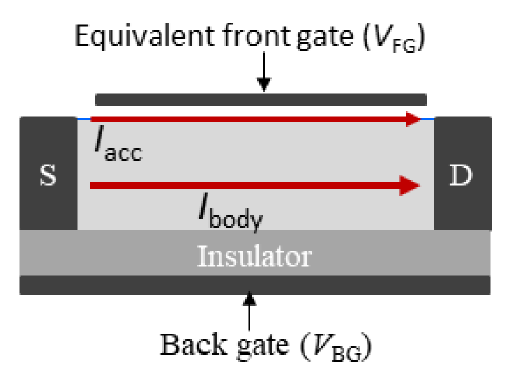
Figure 6. The drain current in the accumulation-mode p -channel transistor consists of the surface accumulation current ( I acc ) and the body current ( I body ). The behavior of the electron-donating or accepting-electron gas in the sensor is equivalent to applying a positive/negative front-gate voltage ( V FG ).